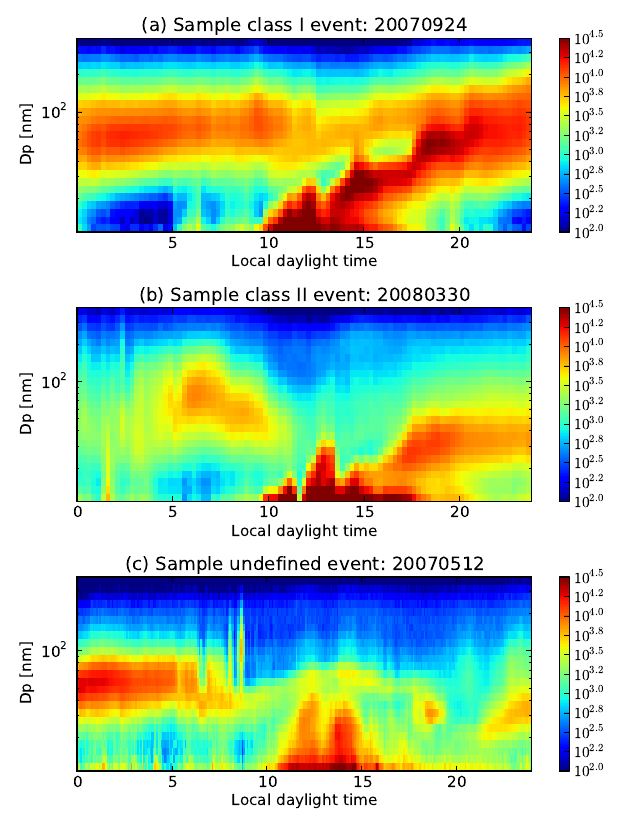
Figure 1. Sample size-distribution time series for a (a) class I nucle- ation day, (b) class II nucleation day and (c) undefined nucleation day. The color axis d N/ dlog D p (cm − 3 ).